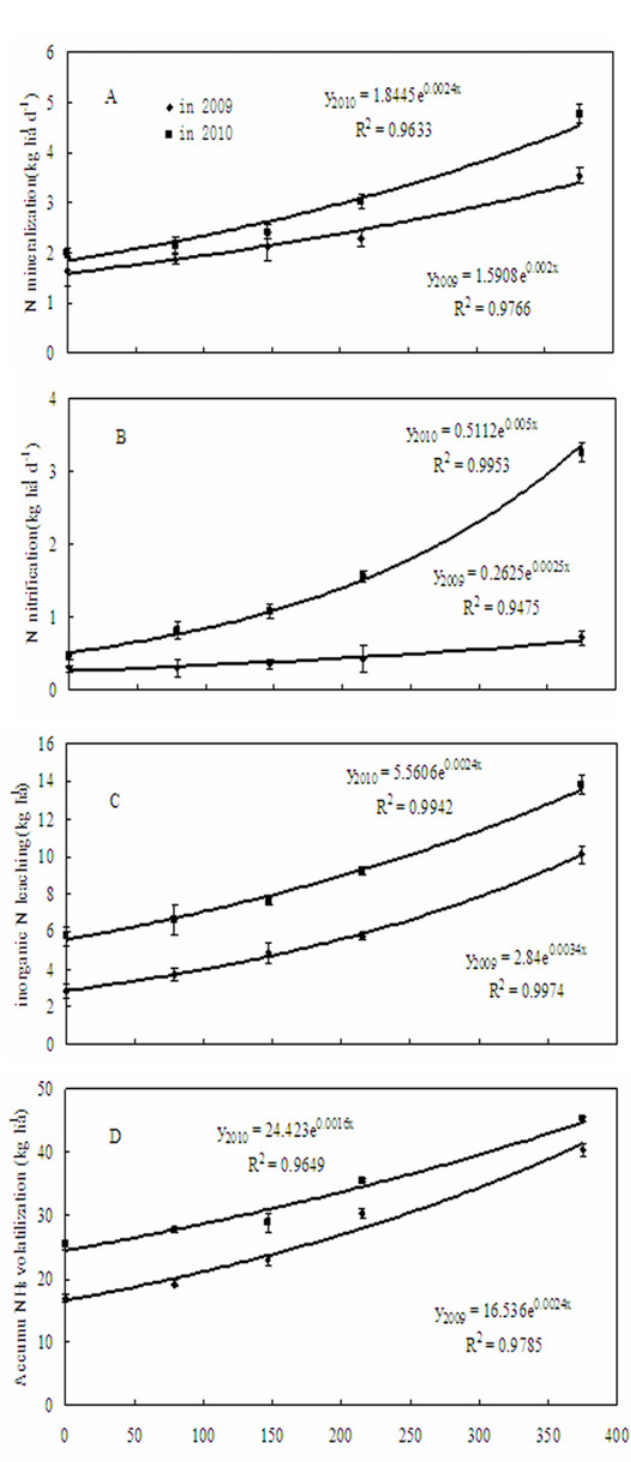
Fig 2. Cumulative net N mineralization, nitrification, inorganic N leaching and NH 3 volatilization at different N rates during maize growth periods in 2009 and 2010. Each point is the mean of 4 replicated plots. Error bars represent ±